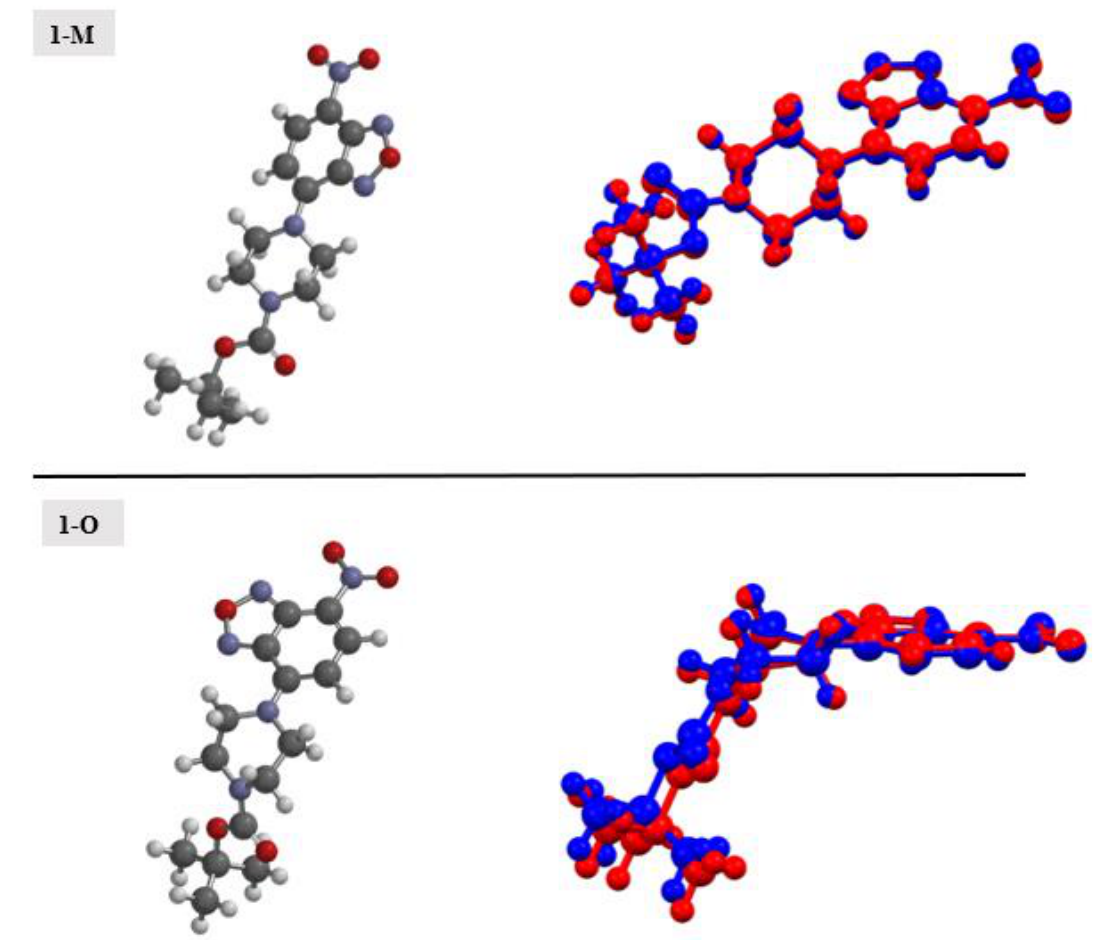
Figure 17. Optimized structures for 1-M and 1-O ( left ). An overlay of the experimental structure (blue) and the calculated structures (red) ( right ).